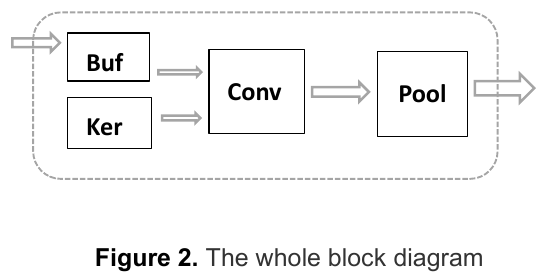
Figure 2. The whole block diagram